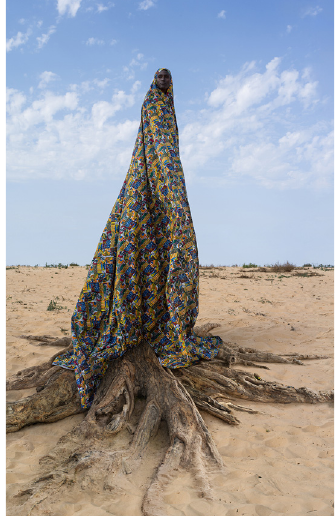
Figure 8. Maïmouna Guerresi, Yaye Fall [Yayfall], 2009. Lambda print on aluminum. 200 × 125 cm. © Maïmouna Guerresi, courtesy Mariane Ibrahim Gallery.